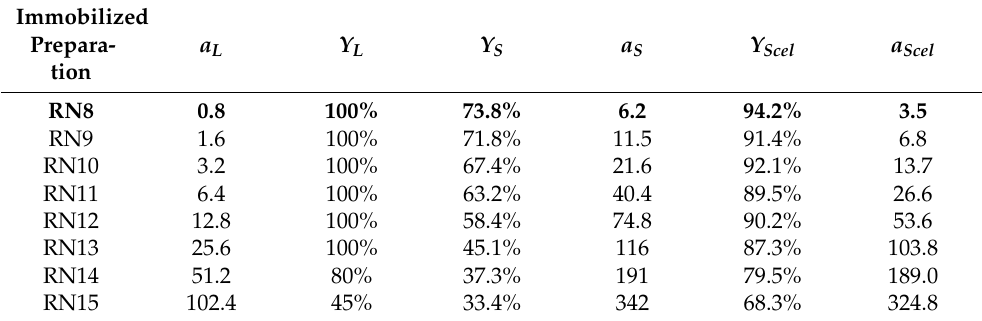
Table 2. Covalent immobilization of the β -glucosidase in the commercial preparation